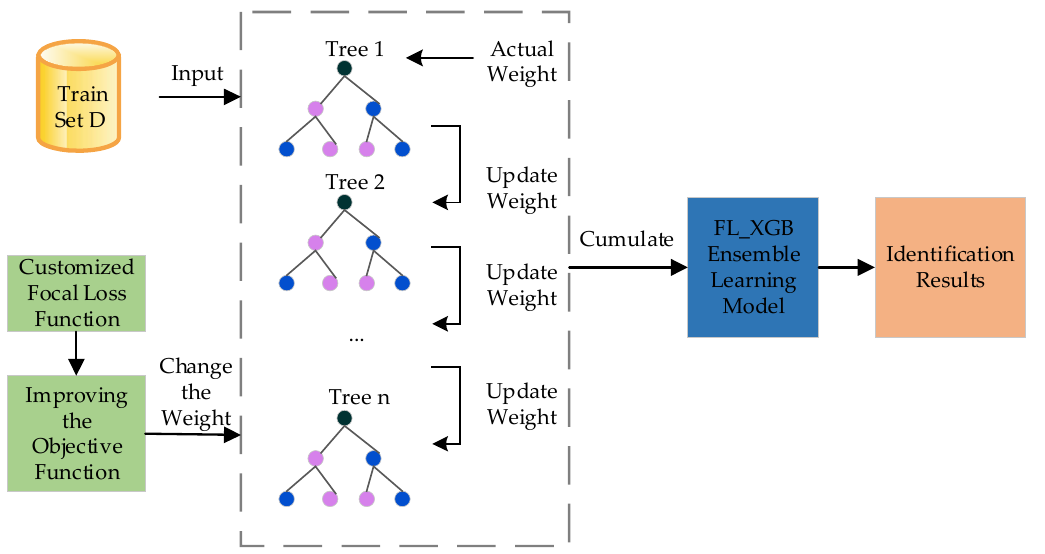
Figure 3. Focal Loss function diagram.